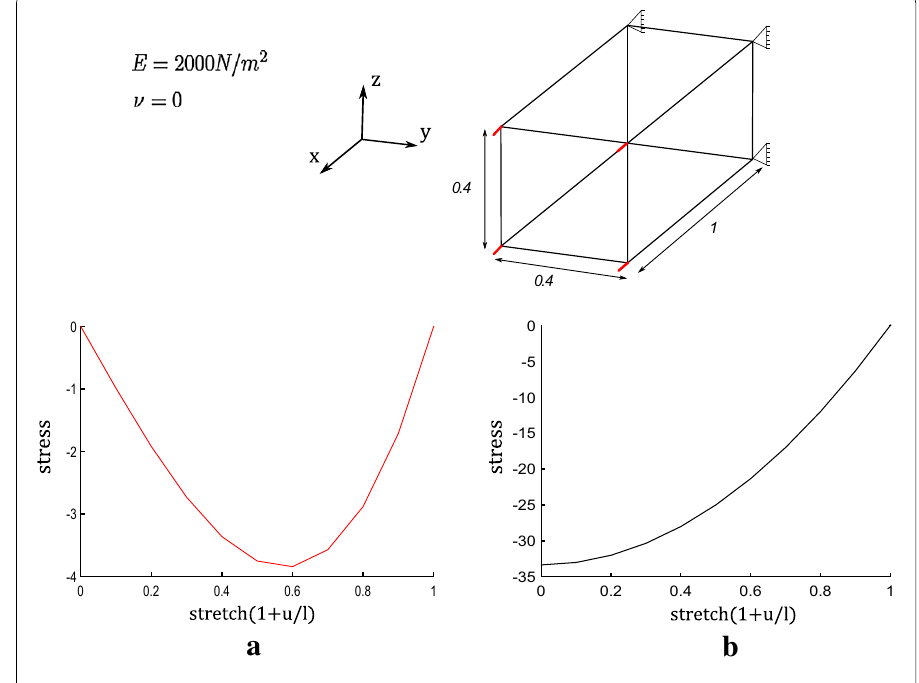
Fig. 1 Short cantilever beam in large compressive deformation; stress as function of stretch: a Green–Lagrange strain measures, b Biot strain